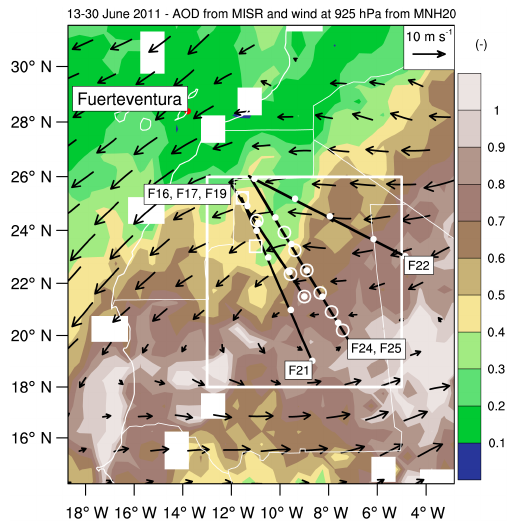
Figure 9. Aerosol optical depth from MISR and wind at 925hPa from MNH20 during the heat low phase (13–30 June 2011). The white rectangle shows the area of interest and the black lines the location of the selected legs of the Falcon flight tracks shown in Fig. 10. The positions of the dropsondes are shown with dots for F16, F21, F22, and F24, open circles for F17 and F25, and squares for